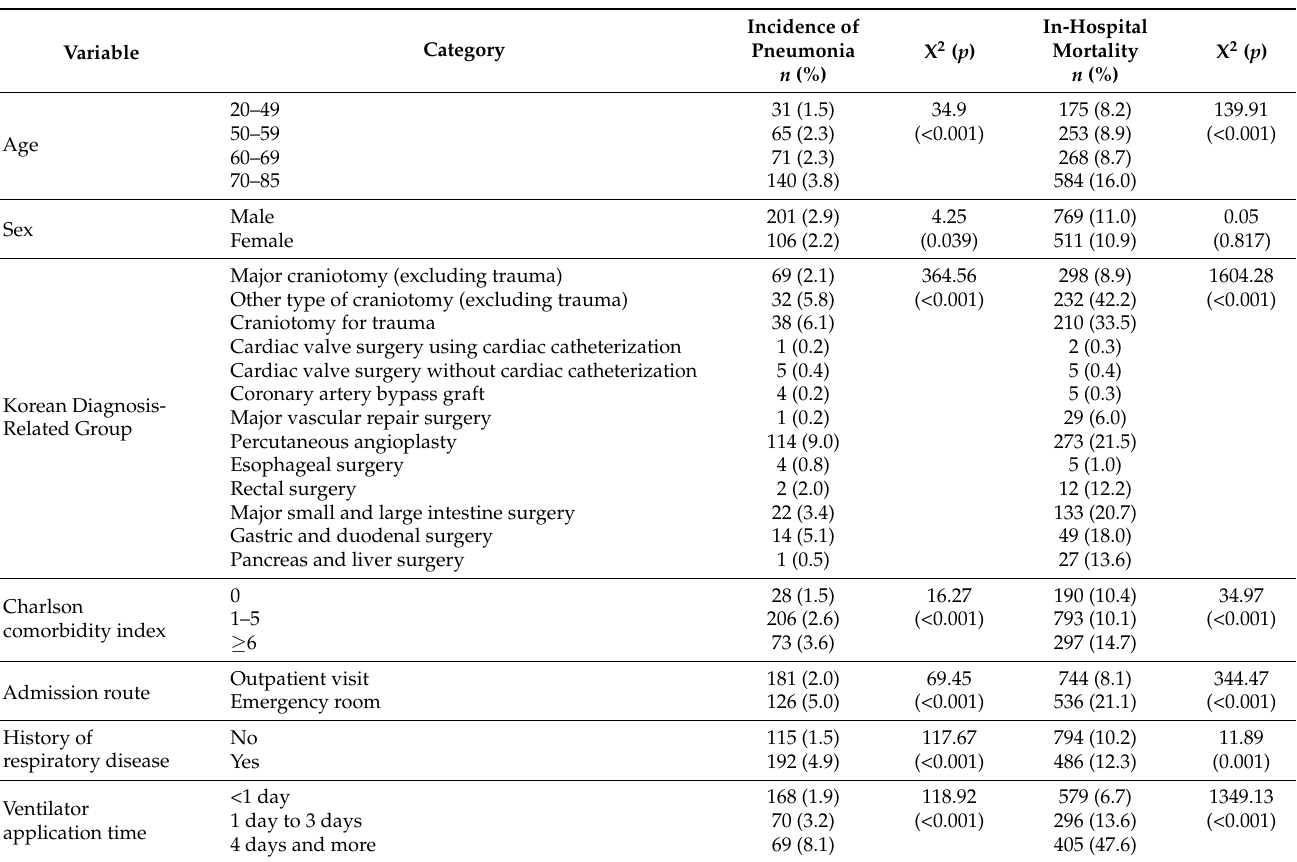
Table 5. Hospital-acquired pneumonia and in-hospital mortality according to patient characteristics ( n =